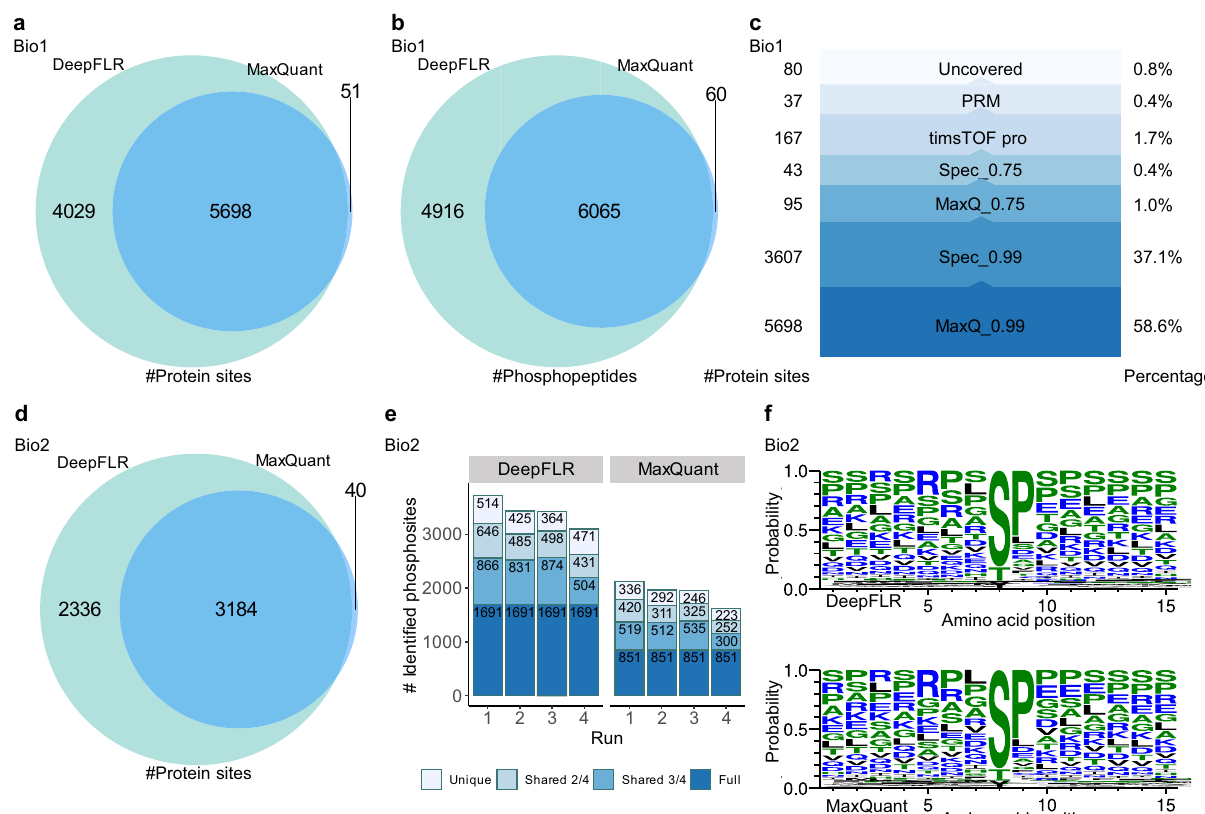
Bio_2. e Histogram of the number of phosphosites identi fi ed among the technical replicatesbyDeepFLRandMaxQuant.Fullrepresentsidenti fi cationsobservedinall the 4 runs; Shared 3/4 represents identi fi cations observed in 3 runs; Shared 2/4 represents identi fi cations observed in 2 runs; Unique represents identi fi cations observed in only 1 run. f Amino acid sequence logo for identi fi ed